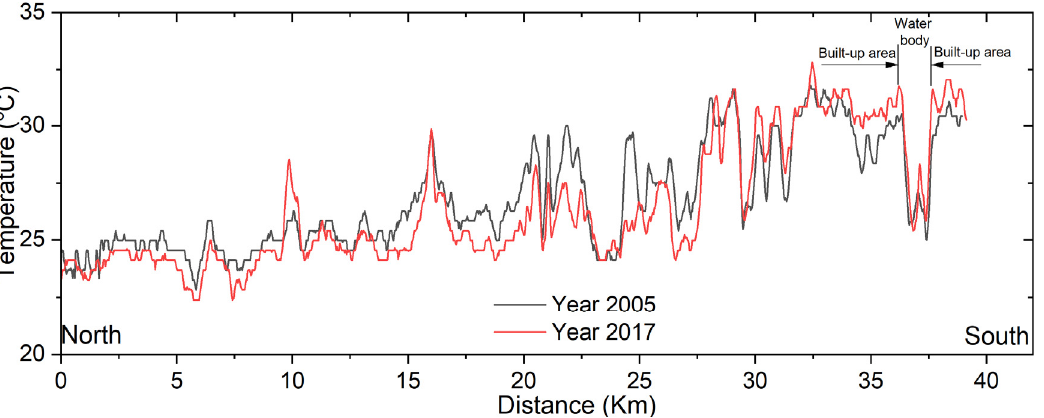
Figure 13. The geographical temperature distribution in the study area from north to south in 2005 and 2017.